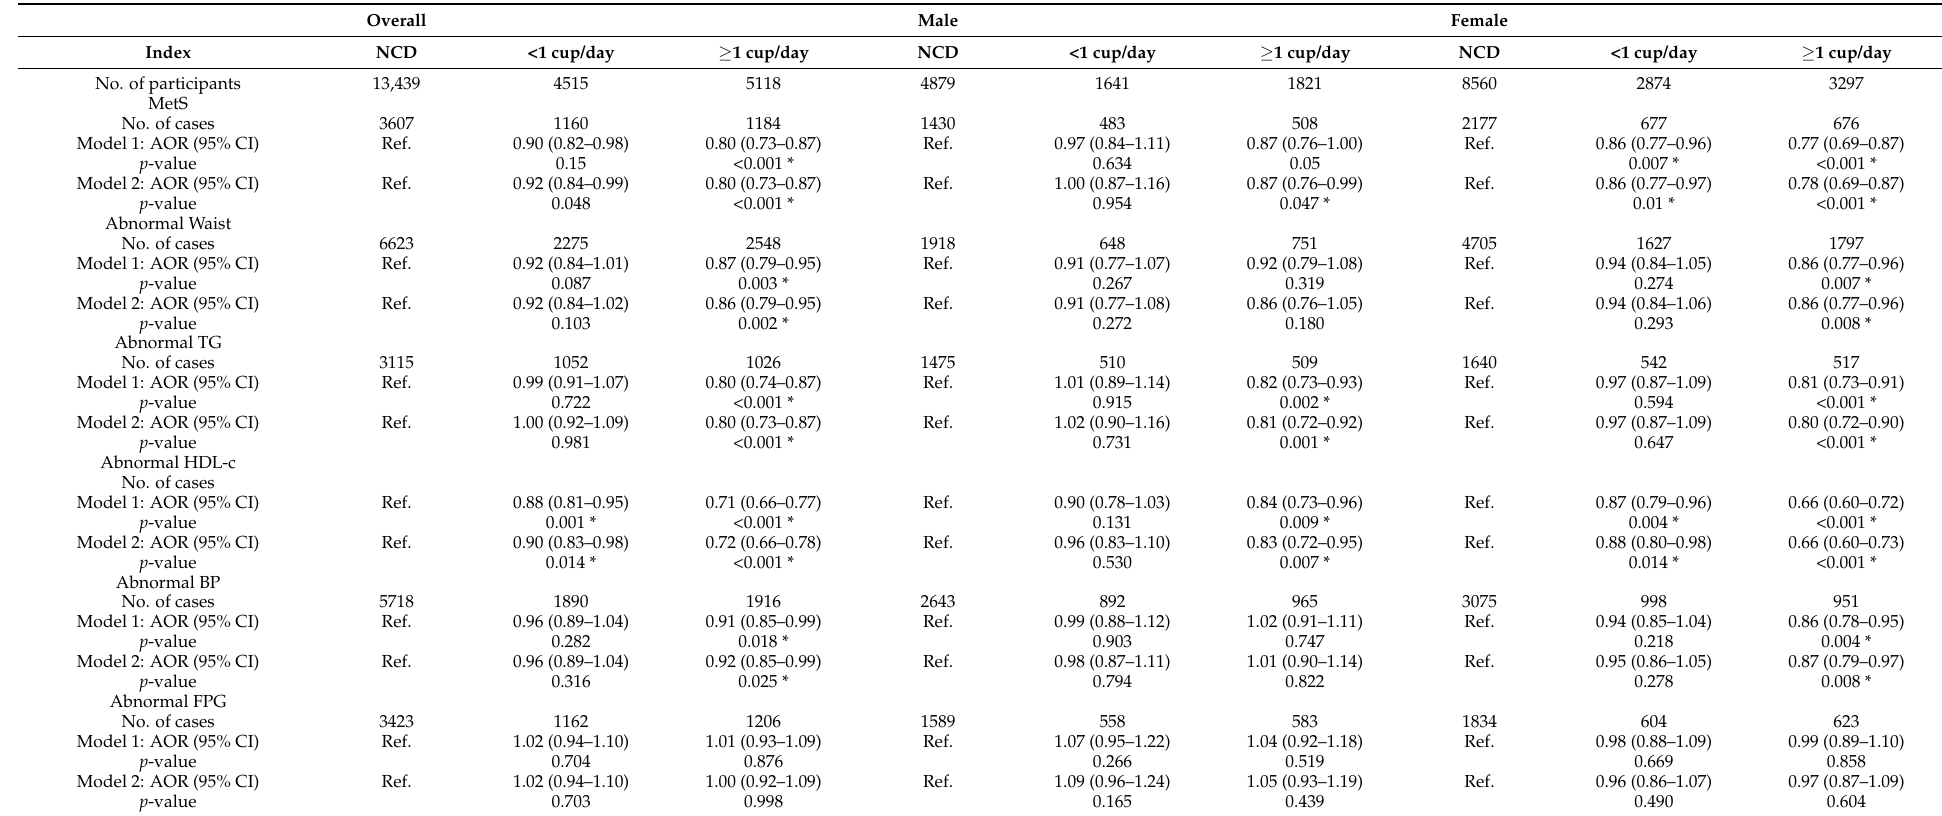
Table 3. The adjusted odds ratio of different daily coffee drinking volume in metabolic parameters in Taiwanese participants aged 30–79